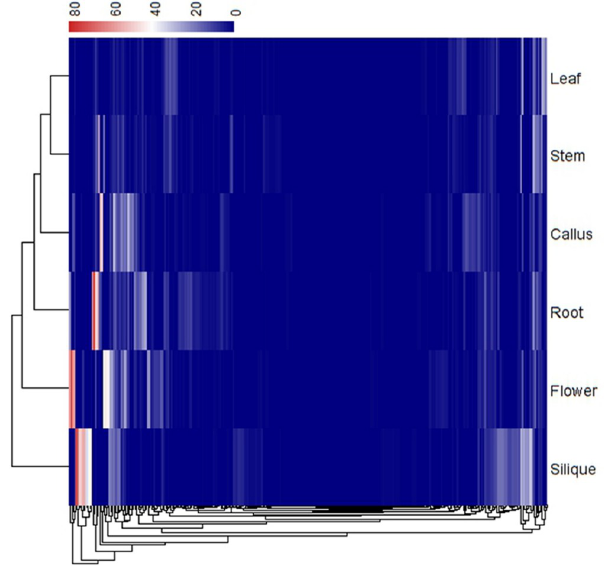
Fig 3. Cluster analysis of the positively selected genes for expression